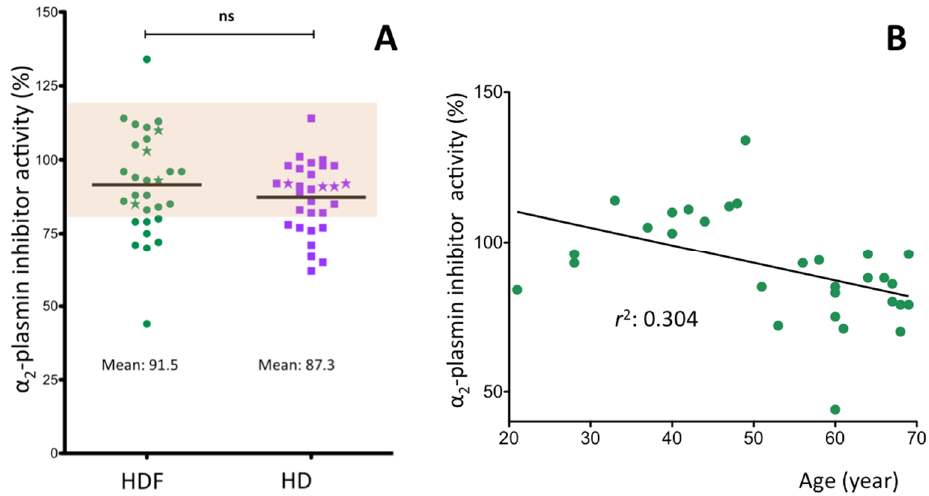
Figure 3. α 2 -plasmin inhibitor activity in ESRD patients. ( A ) patients being on chronic HDF treatment or after switching to HD treatment for two weeks. ( B ) correlation of α 2 -plasmin inhibitor activity with patients’ age. The coefficient of determination ( r 2 ) is also shown in the figure. The asterisks on Figure A represent the four patients with the highest CRP levels.